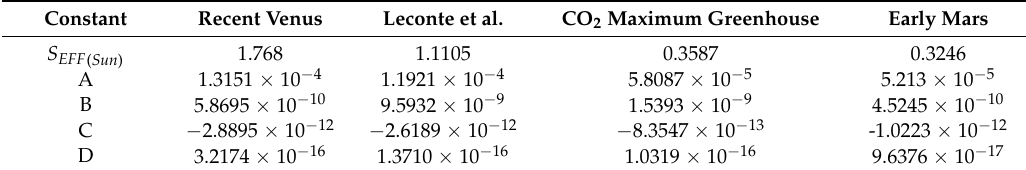
Table 1. Revised coefficients for the extended classical habitable zone (HZ) (atmospheric composition N 2 -CO 2 -H 2 O) and the empirical HZ for host stars with T EFF = 2600–10,000 K *. S EFF —effective stellar